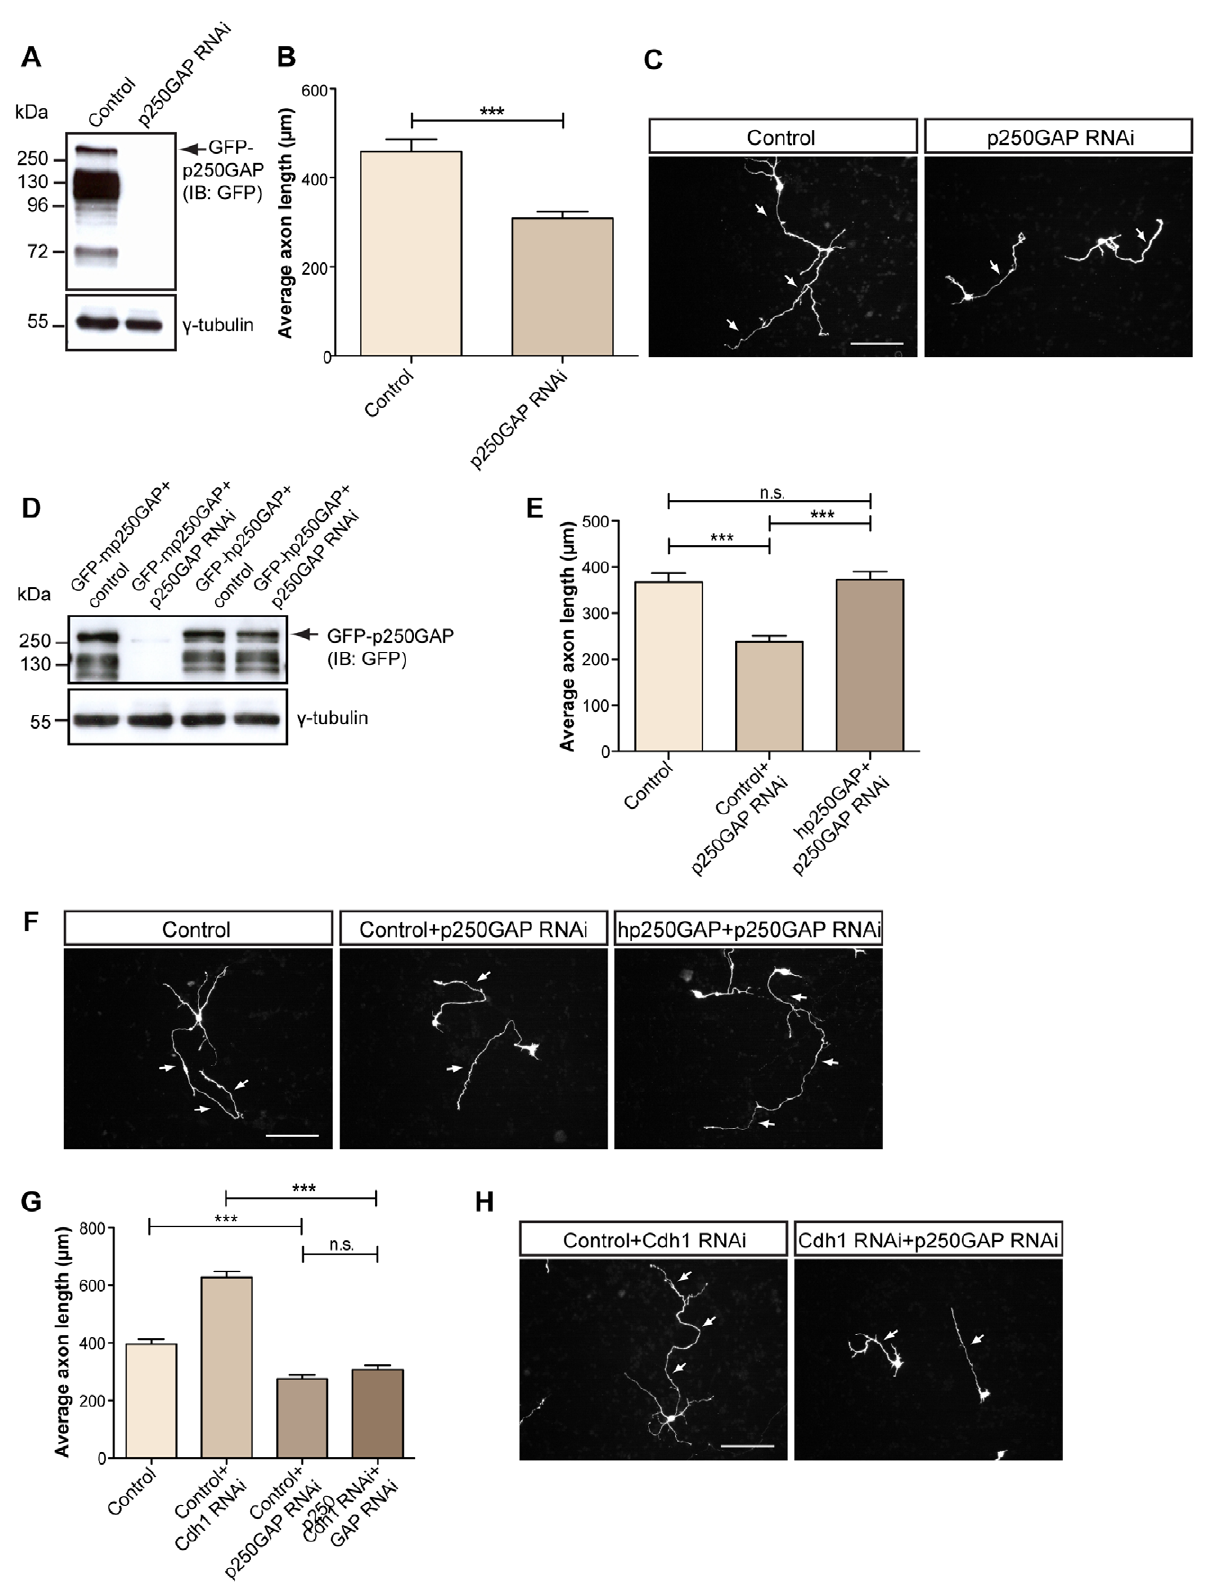
Figure 2. p250GAP promotes axon growth. A. Lysates of 293T cells transfected with GFP-p250GAP plasmid together with control vector U6 or the p250GAP RNAi plasmid were subjected to immunoblotting using the GFP antibody. c -tubulin served as the loading control. B. Cerebellar granule neurons were transfected at DIV 0 with control vector U6 or the p250GAP RNAi plasmid together with GFP and BCL XL plasmids and maintained in